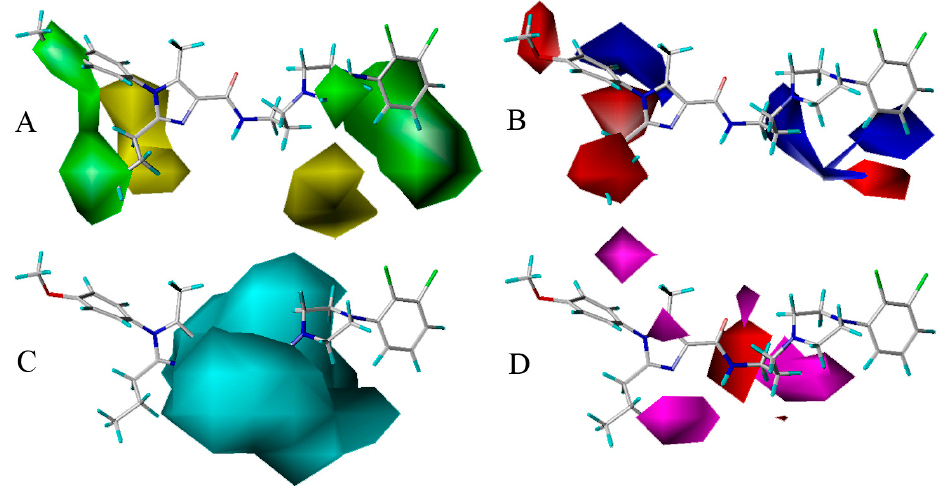
Figure 5. CoMSIA “StDev*Coeff” contour maps. ( A ) Steric (green/yellow) map. Green contours imply regions where bulky groups are beneficial for the activity, and yellow contours imply regions where bulky groups are detrimental for the activity; ( B ) Electrostatic (blue/red) map. Blue contours represent where positive charges promote the affinity, and red contours represent where negative charges promote the affinity; ( C ) H-bond donor (cyan/purple) map. Cyan contours reveal where H-bond donors increase the activity, and purple contours reveal where H-bond donors decrease the activity; ( D ) H-bond accepter (purple/red) map. Purple contours represent regions where H-bond acceptors are beneficial for the activity, while red contours represent regions where H-bond acceptors are detrimental for the activity.